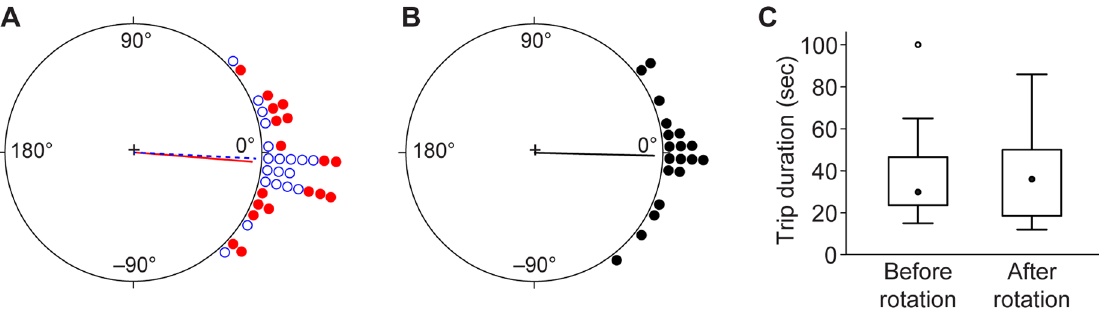
Figure 2. Substrate rotation does not affect orientation by emigrating ants. A) The last trips before rotation (dashed blue line and open blue circles) were highly directed (Rayleigh test: r=0.95, p=6 6 10 2 8 ), with an average heading only 3 u from the direction of the new nest (0 u ). After rotation (solid red line and closed red circles), headings remained highly directed (Rayleigh test: r=0.93, p=9 6 10 2 8 ), with an average value only 4 u from the nest direction. The difference in mean headings before and after rotation was not significant (Watson’s two-sample test: U 2 =0.1541, 0.10 . p . 0.05, n=19). B) The mean change in heading by each ant could not be distinguished from zero (Hotelling test: F 2, 17 =0.32, p=0.73). C) The duration of journeys from the old to the new nest was not affected by rotation (Wilcoxon paired ranks test: V=62.5, n=19, p=0.30). In each box plot the closed circle shows the median, boxes delimit the 1 st and 3 rd quartiles, and whiskers show the range. The open circle is an outlier. doi:10.1371/journal.pone.0064367.g002 counterclockwise from the true bearing of the new nest. After rotation, the ants remained highly directed, but with an average heading 65 u clockwise from the true bearing. The average change in heading across ants was 67 u (Figure 7B), well above 0 u , but somewhat less than the 90 u rotation predicted if the ants’ paths were determined entirely by the position of the rotated visual cues (95% confidence interval: 53 u to 83 u ). The ants walked directly